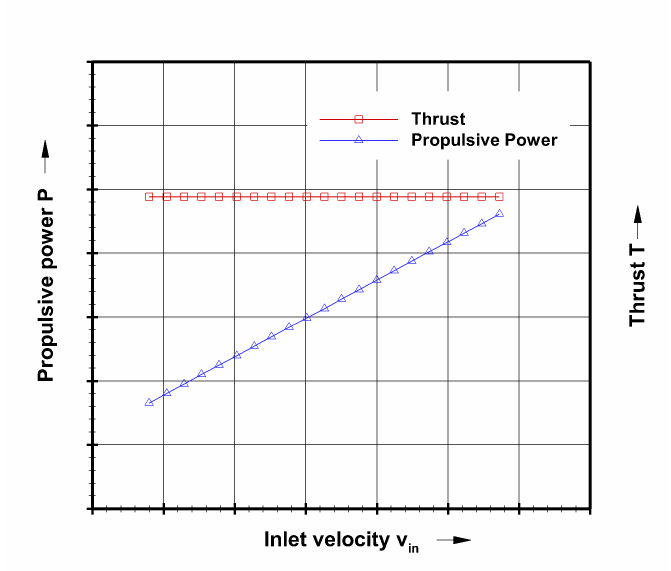
Figure 1. Necessary power for a constant thrust at varying inlet